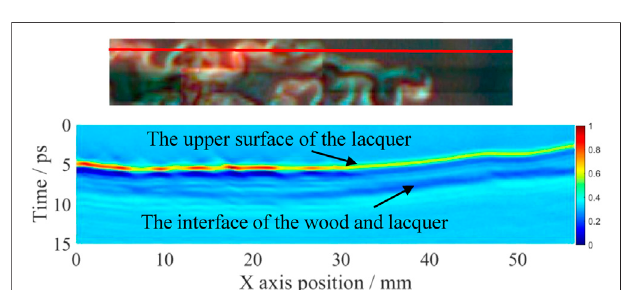
FIGURE 8 | B-scan image. The fi gure has been